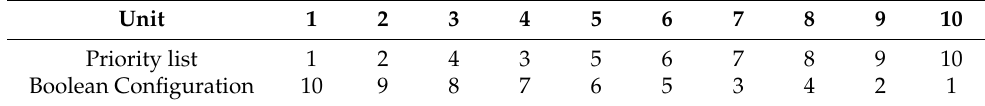
Table 3. Enhanced priority-list scheme